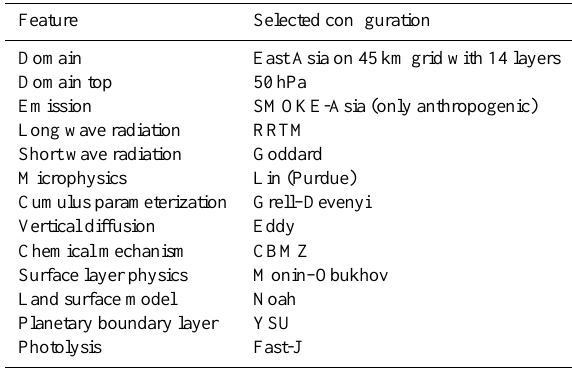
Table 1. Model set-up for the WRF-Chem simulations.